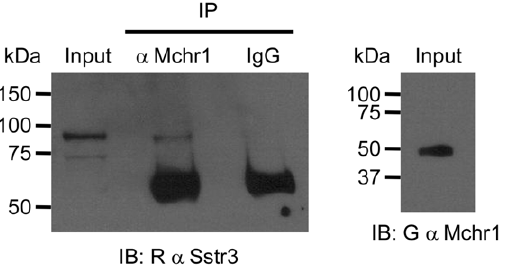
Figure 7. Mchr1 and Sstr3 interact in mouse hippocampal lysate. Membrane protein enriched cell lysate from the hippocampus of 5 week old adult WT mice was immunoprecipitated (IP) with a goat anti-Mchr1 antibody or goat IgG, as a negative control. Immunopre- cipitates were analyzed by western blotting (IB) with a rabbit anti-Sstr3 antibody. Note that Sstr3 is immunoprecipitated with Mchr1 but not with the IgG negative control. The input probed with anti-Sstr3 (left) or anti-Mchr1 (right), confirms the expression of Sstr3 and Mchr1. The , 55 kDa bands in the IP lanes may be IgG heavy chain that is detected due to cross-reactivity of the secondary